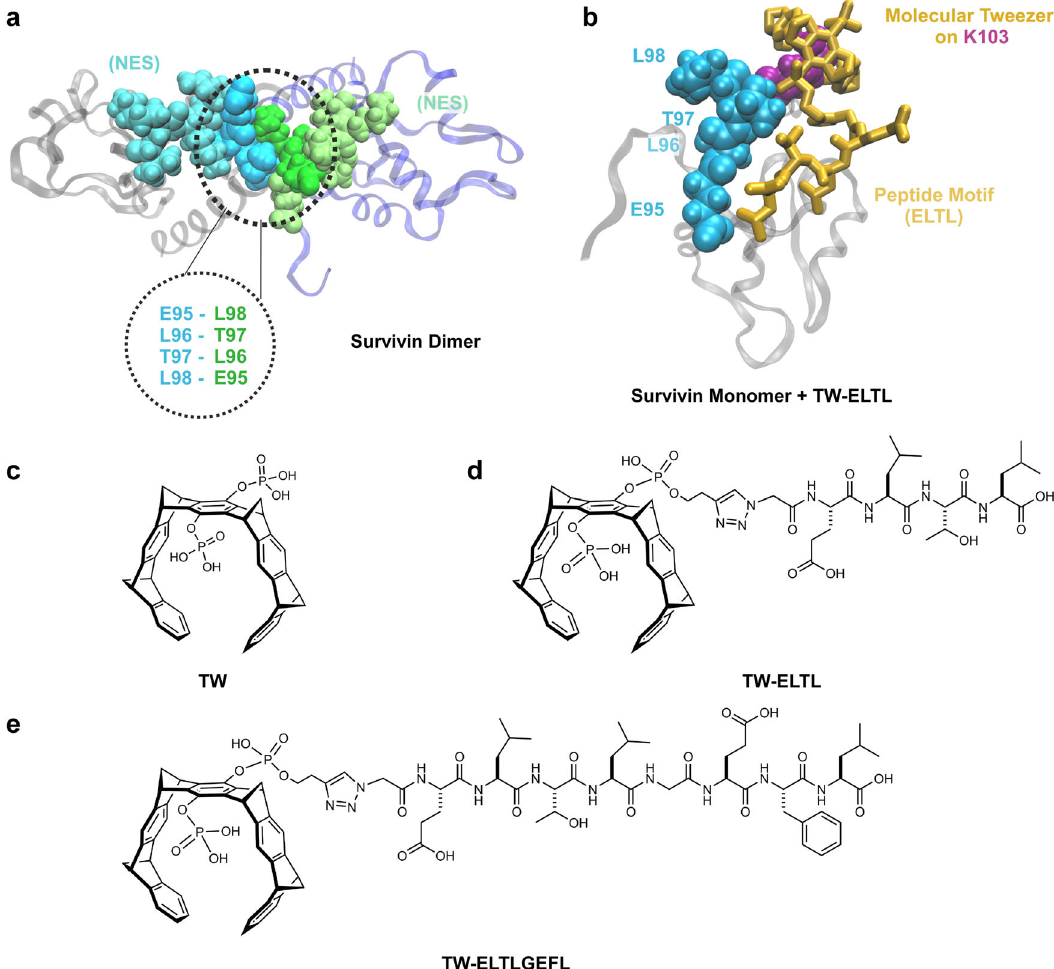
Fig. 1 Design of peptide-modi fi ed supramolecular tweezers. a Representation of Survivin ’ s dimer interface based on PDB-ID: 1XOX [https://www.rcsb. org/structure/1xox] 38 . Both monomers, depicted in blue and gray, mainly interact via the ELTL sequence (contact region of both monomers overlapping with the NES, represented in cyan and green). This sequence was chosen as second binding motif for the peptide-modi fi ed tweezer molecules. b Representation of TW-ELTL (shown in d ) bound to Survivin. TW-ELTL (yellow) binds the anchor lysine residue K103 (violet) on Survivin ’ s surface while the peptide motif ELTL (yellow) interacts with the ELTL region of the Survivin monomer (cyan). This is the same region of the dimer interface represented in Fig. 1a, overlapping with the NES (cyan). The chemical structures of the unmodi fi ed tweezer molecule TW ( c ), an asymmetrical tweezer molecule linked to the short peptide ELTL (TW-ELTL) ( d ), and an asymmetrical tweezer molecule linked to the elongated peptide ELTLGEFL (TW-ELTLGEFL) ( e ) are